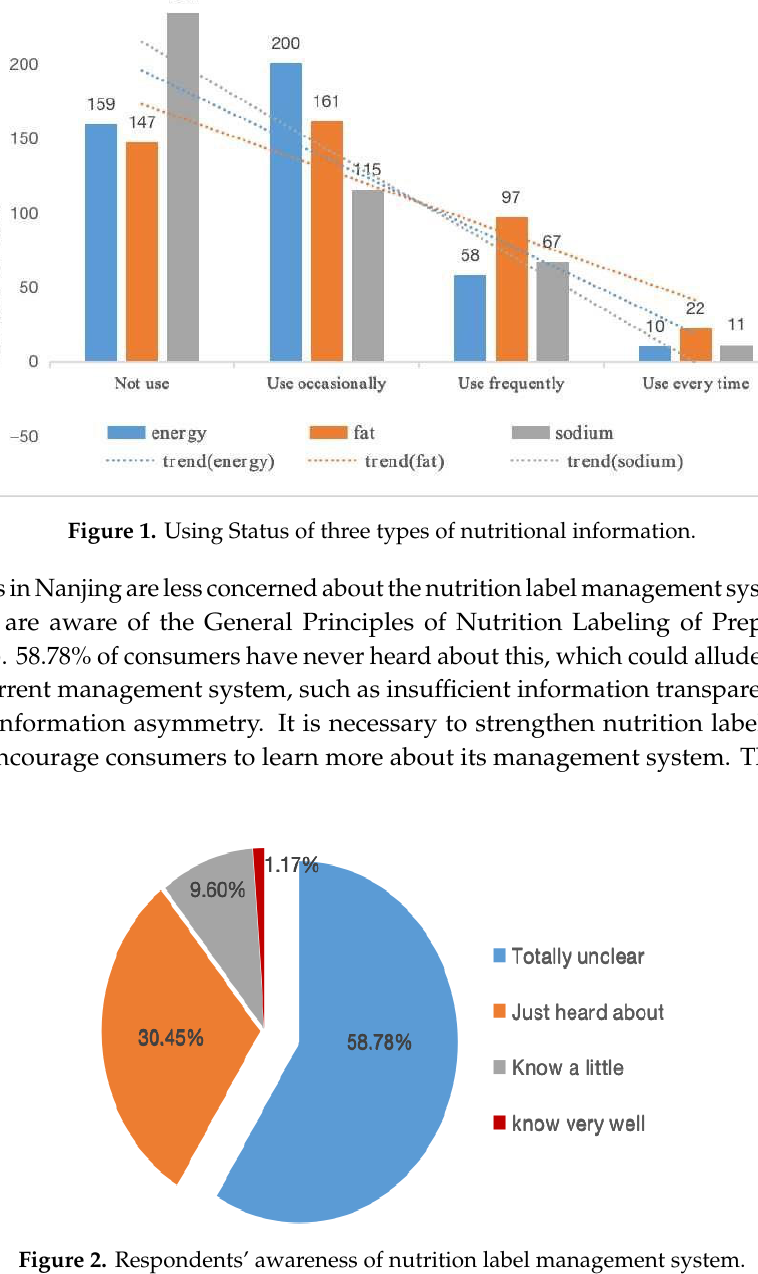
Figure 2. Respondents’ awareness of nutrition label management system.